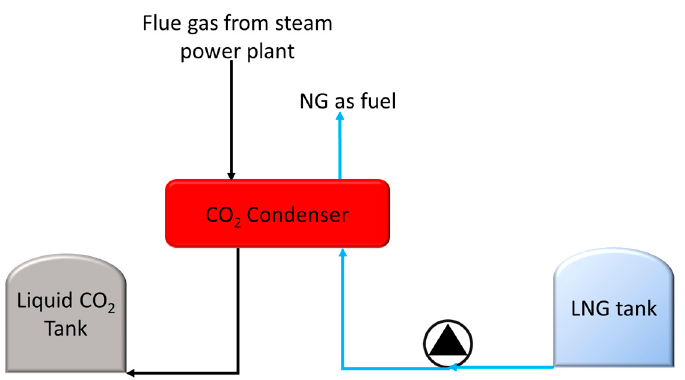
Figure 6. Cryogenic CO 2 capture using LNG cold energy